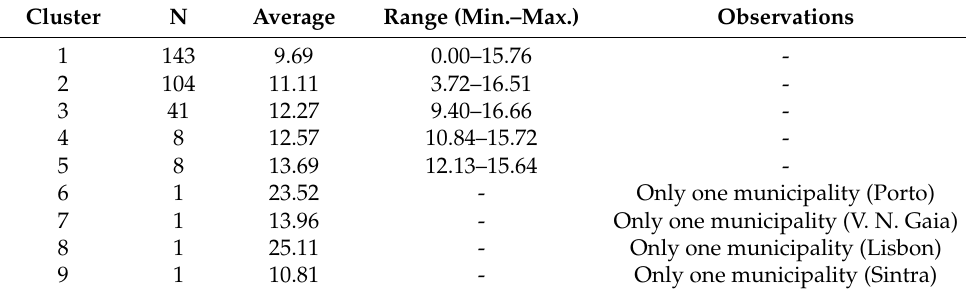
Table 2. Periodontitis normalized risk score for each cluster.